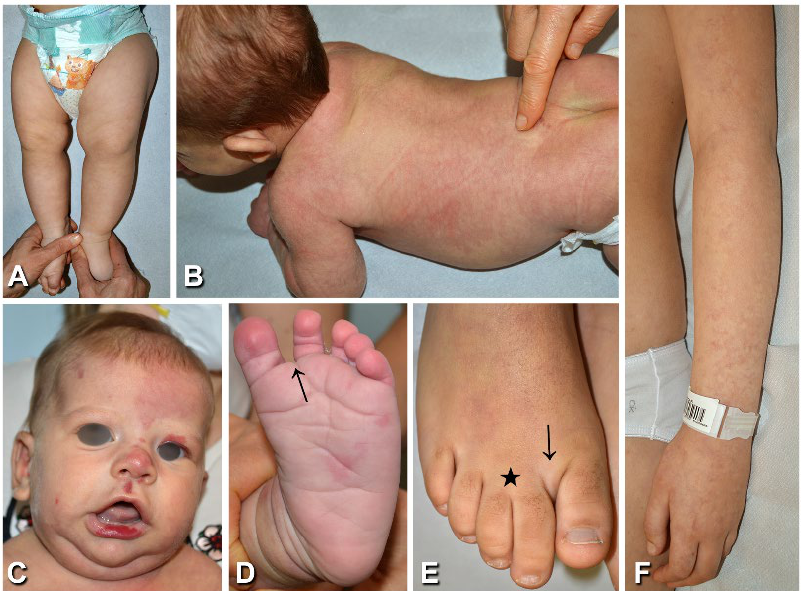
Figure 3. Clinical findings of patients presenting diffuse capillary malformation with overgrowth: Reticulate capillary malformation with overgrowth of the left lower limb in case n. 14 (Table 1), at 7 months of age ( A ); in this patient the capillary malformation was also present on the trunk and face, with vermillion stain. A 2-month-old patient (Table 1, n. 16) with a diffuse reticulate capillary malformation of the trunk and limbs ( B ), also involving the feet ( D ), and a homogeneous capillary malformation of the left forehead and centrofacial region, including philtrum and vermillion stain ( C ); note the sandal gap ( D, arrow) and triangular shape of the left foot ( D ). Sandal gap (arrow), proximal syndactyly of toes 2–3 (asterisk), and macrodactyly of toe 2 ( E ) in a 10-year-old female (Table 1, n. 23). Reticulate capillary malformation of the left upper limb ( F ) in a 10-year-old female, who presented similar lesions over most of the body’s surface (Table 1, n.